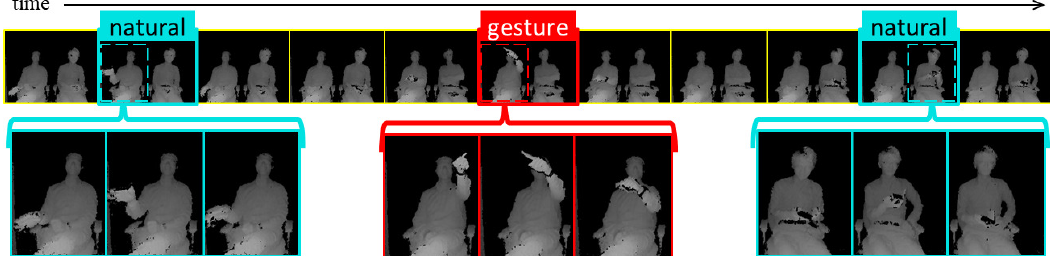
Figure 1. An example of the captured behavior of driver and passenger when interacting with an in-car touchless interface. “Natural” refers to natural behaviors of users’ hands, and “gesture” to target gestures. ( top ) A raw sequence from a depth video captured inside an autonomous car. ( left ) A spontaneous gesture of the driver when interacting with the passenger. ( center ) Example of a target gesture that triggers a command on the interface. ( right ) Interaction of the passenger with an object